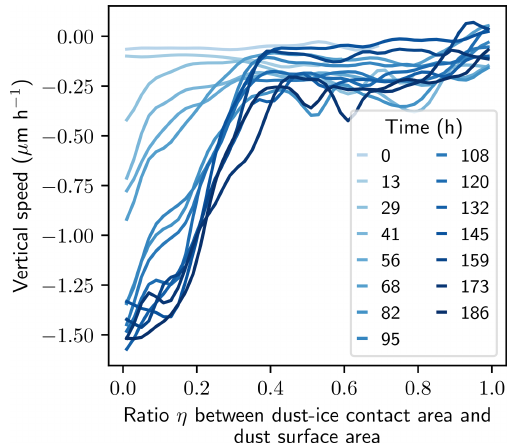
Figure 5. Link between dust movement (types 1 and 2) and relative position to ice quantified by η in the temperature gradient experi-